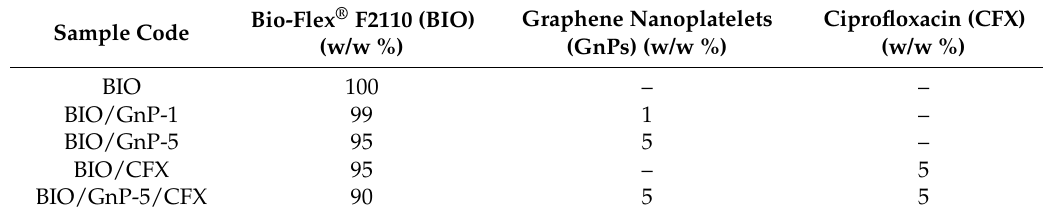
Table 1. Composition of samples and their